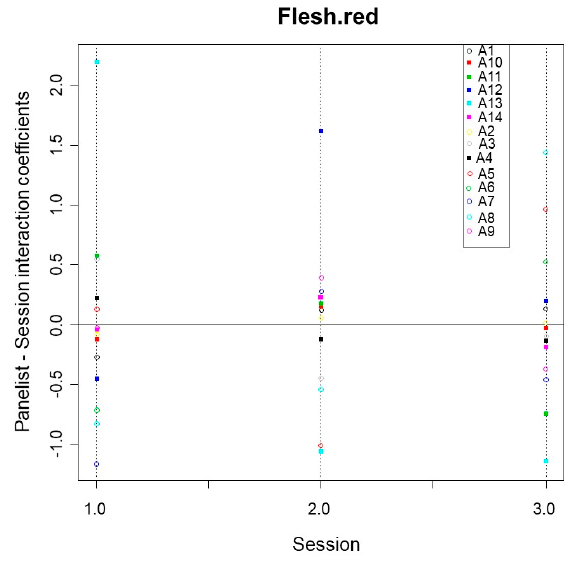
Figure 6. Panel performance. Panelist-session interaction. Detail of the coefficients through the three sessions for the flesh red descriptor.